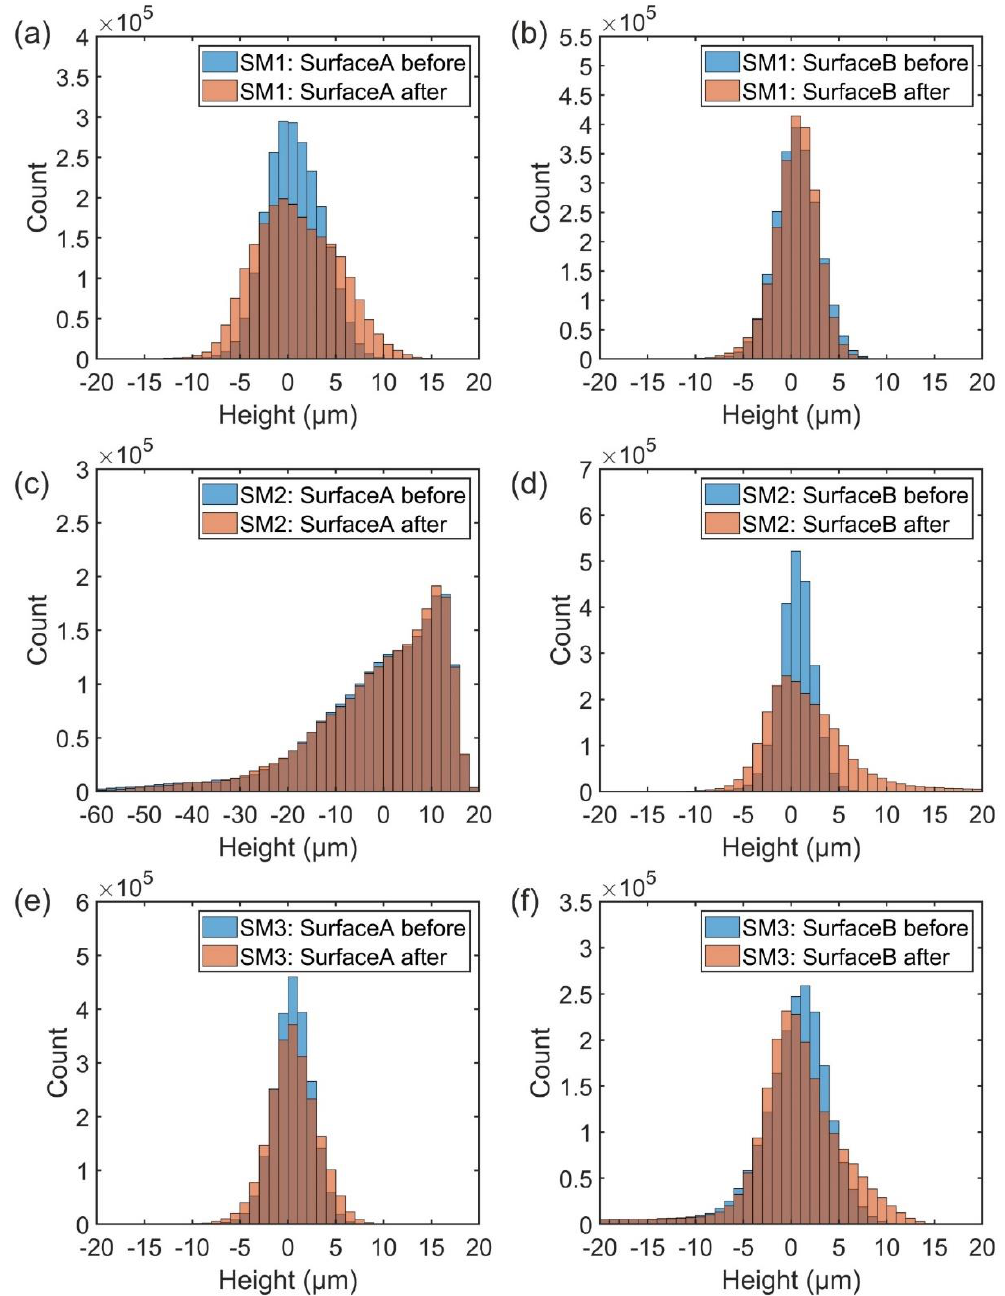
Figure 8. Comparison of fracture surface height distribution before and after the experiments, two surfaces ( a , b ) for sample SM1, ( c , d ) for sample SM2, ( e , f ) for sample SM3, respectively. Table 4. Statistical parameters of fracture surface roughness before and after the flow-through experiments. Parameters